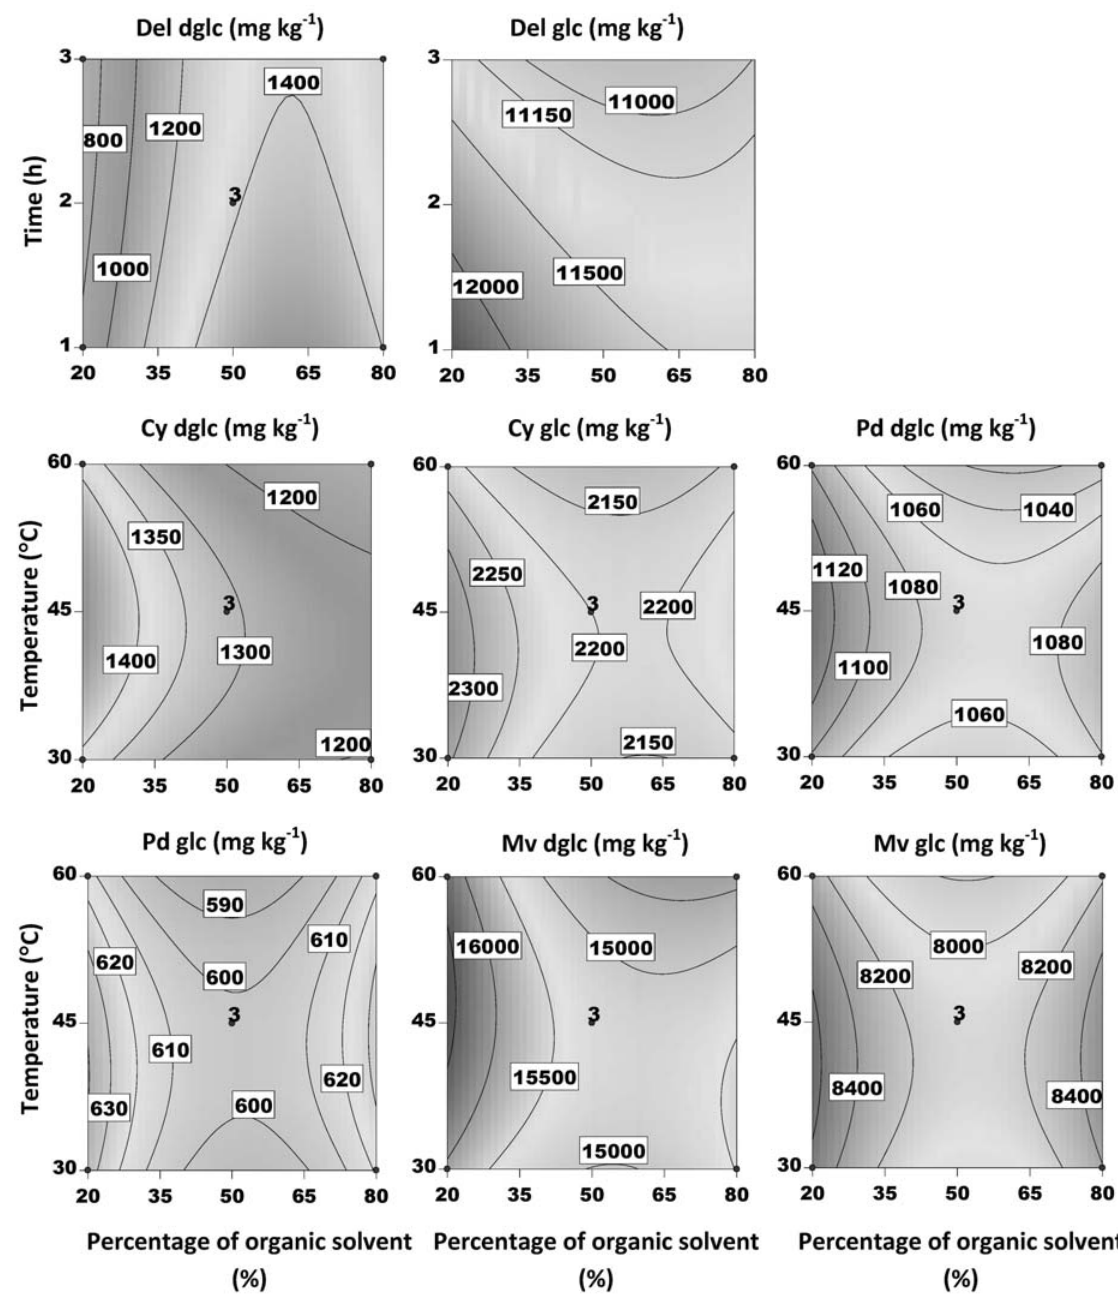
Fig. 3. C ontour plots of most prominent interaction factors for individual anthocyanins from grape skins using acetonitrile as organic modifier. Cy dglc – Cyanidin-3,5- O -diglucoside; Cy glc – Cyanidin-3- O -glucoside; Del glc – Delphinidin-3- O -glucoside; Del dglc – Delphinidin-3,5- O -di- glucoside; Mv dglc – Malvidin-3,5- O -diglucoside; Mv glc – Malvidin-3- O -glucoside; Pd dglc – Peonidin-3,5- O -diglucoside; Pd glc – Peonidin-3- O